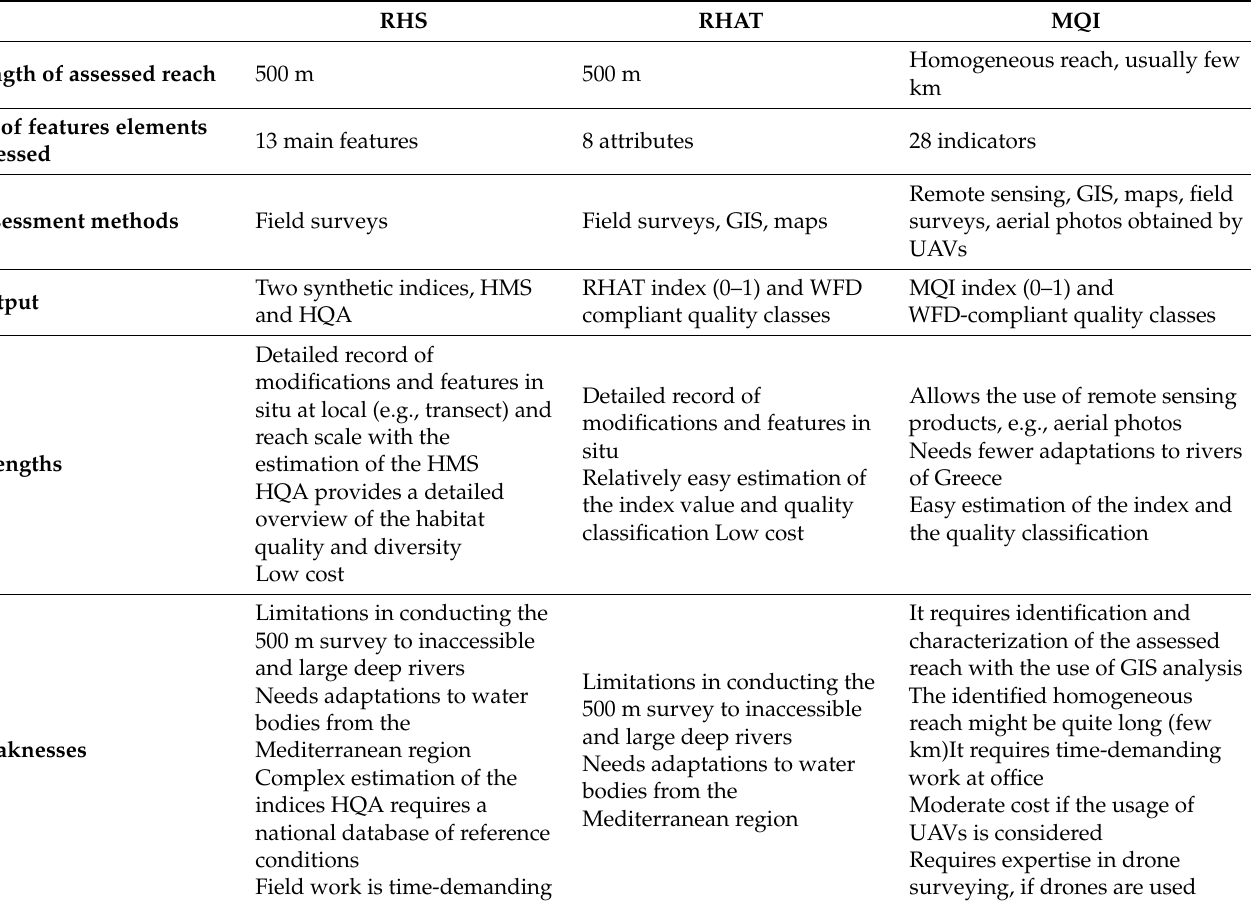
Table 3. A comparison of the three methods currently used for hydromorphological assessment of rivers in Greece. RHS